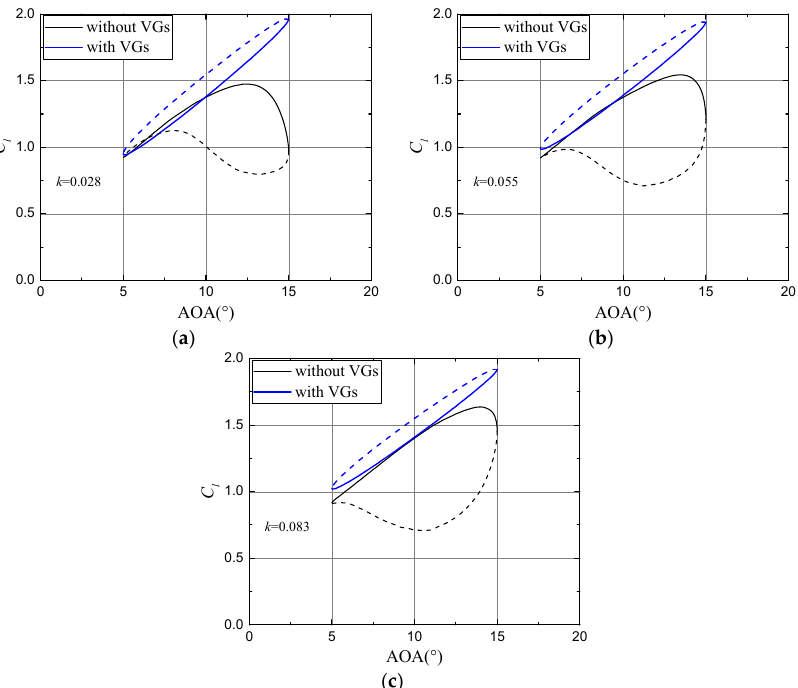
Figure 10. Aerodynamic hysteresis of the lift coefficient with and without the baseline VGs at different reduced frequencies. Solid lines denote increasing AOA, and dashed lines decreasing AOA. α mean = 10 ◦ and A = 5 ◦ . ( a ) k = 0.028; ( b ) k = 0.055; ( c ) k = 0.083. The C l hysteresis intensity is measured by: